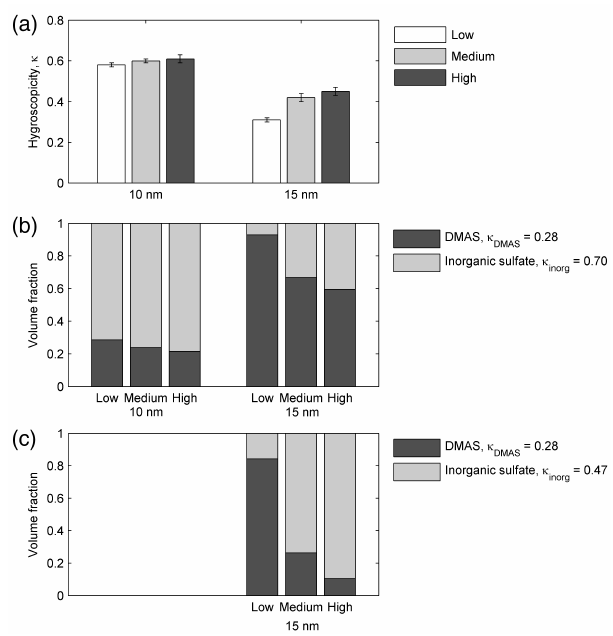
Figure 3. (a) Comparison of hygroscopicity of 10 and 15nm par- ticles produced from sulfuric acid and dimethylamine. (b–c) Esti- mated volume fractions in the particles depending on UV aperture (Exps. B–D) assuming the inorganic fraction was (b) sulfuric acid and had a hygroscopicity κ = 0 . 70 and (c) ammonium sulfate and had a hygroscopicity κ = 0 . 47. The concentrations of sulfuric acid were 5 . 1 × 10 6 , 7 . 6 × 10 6 , and 12 . 3 × 10 6 moleculescm − 3 for low, medium, and high,